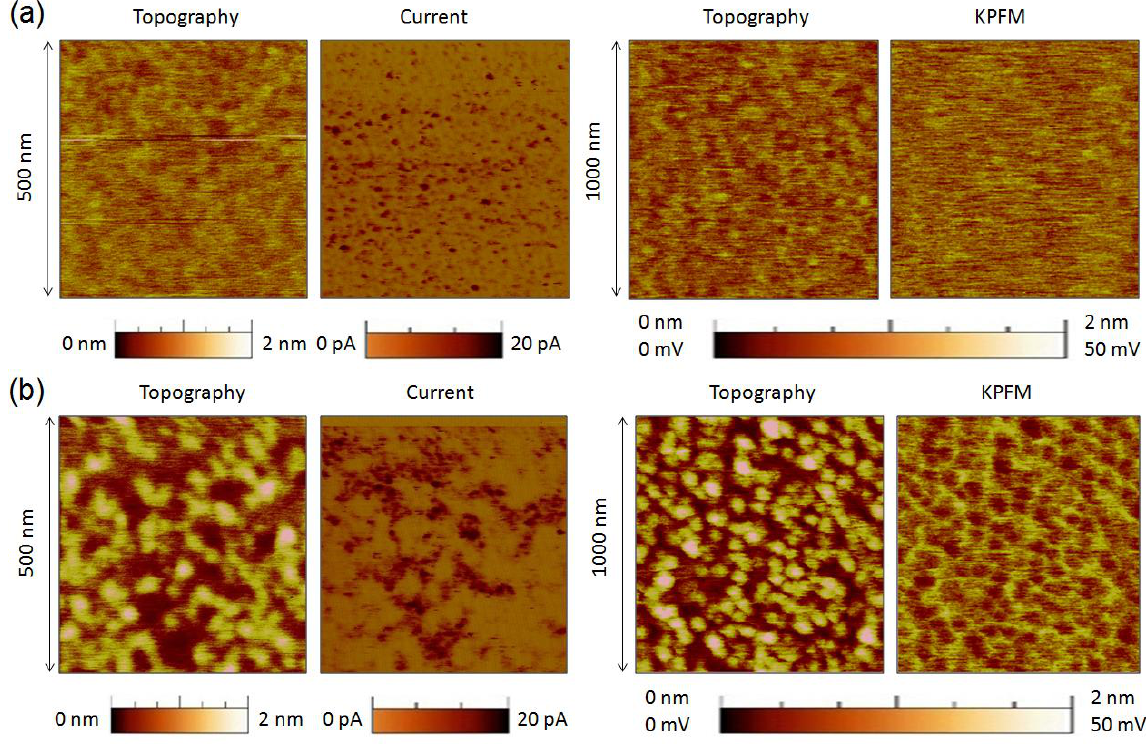
Figure 8. Simultaneously collected topography-current ( left ) and topography-CPD images ( right ) on the surface of ( a ) non-annealed and ( b ) annealed at 1000 °C 2.5 nm-HfO /1 nm-SiO /Si stack. The images clearly show structural and electrical 2 2 properties